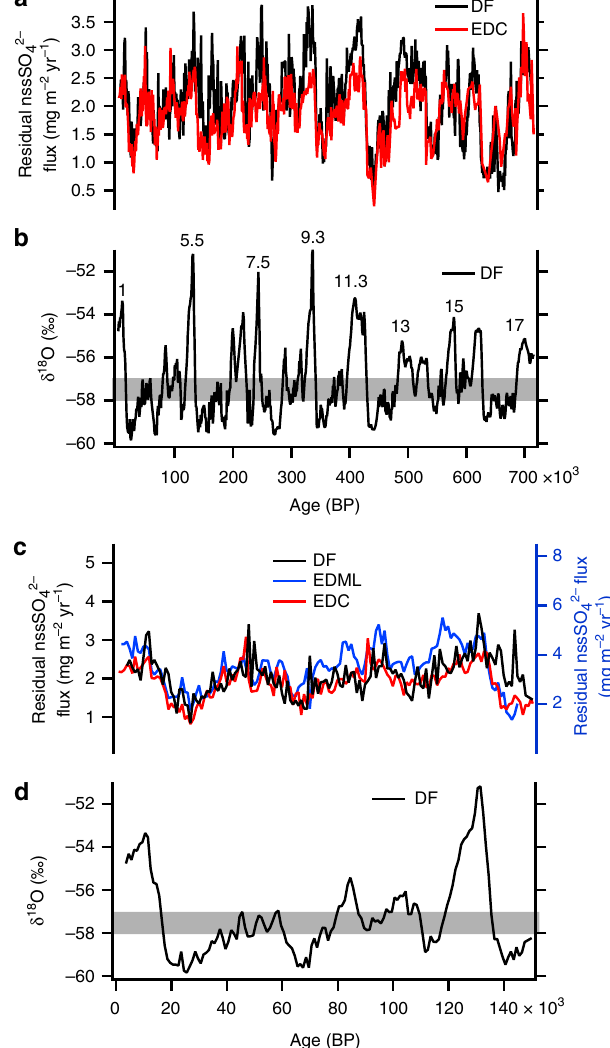
Fig. 3 Variability of residual nssSO 4 2 − fl ux at Dome Fuji (DF), Dome C (EDC), and Dronning Maud Land (EDML). a Residual nssSO 4 2 − fl ux at